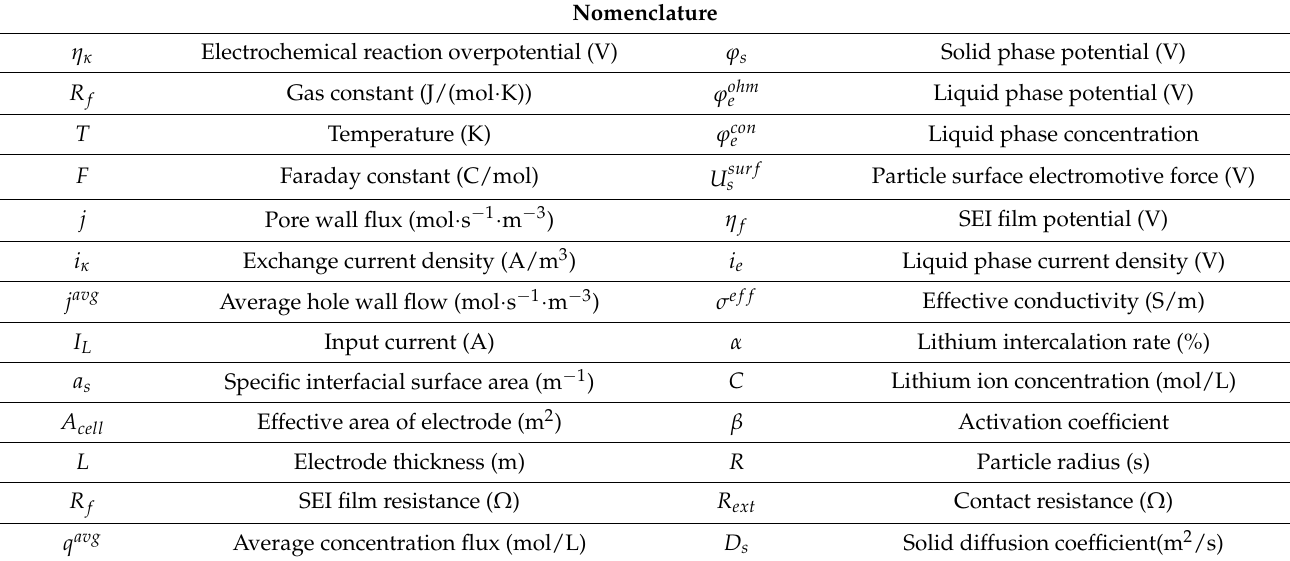
Table 1. Nomenclature of symbols used in